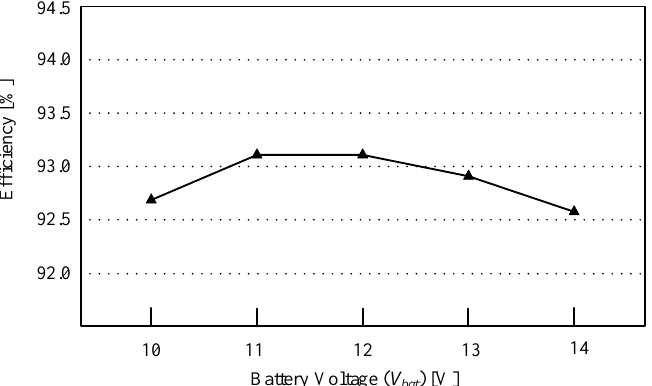
Figure 12. The overall efficiency at half load depending on the charged battery voltage.